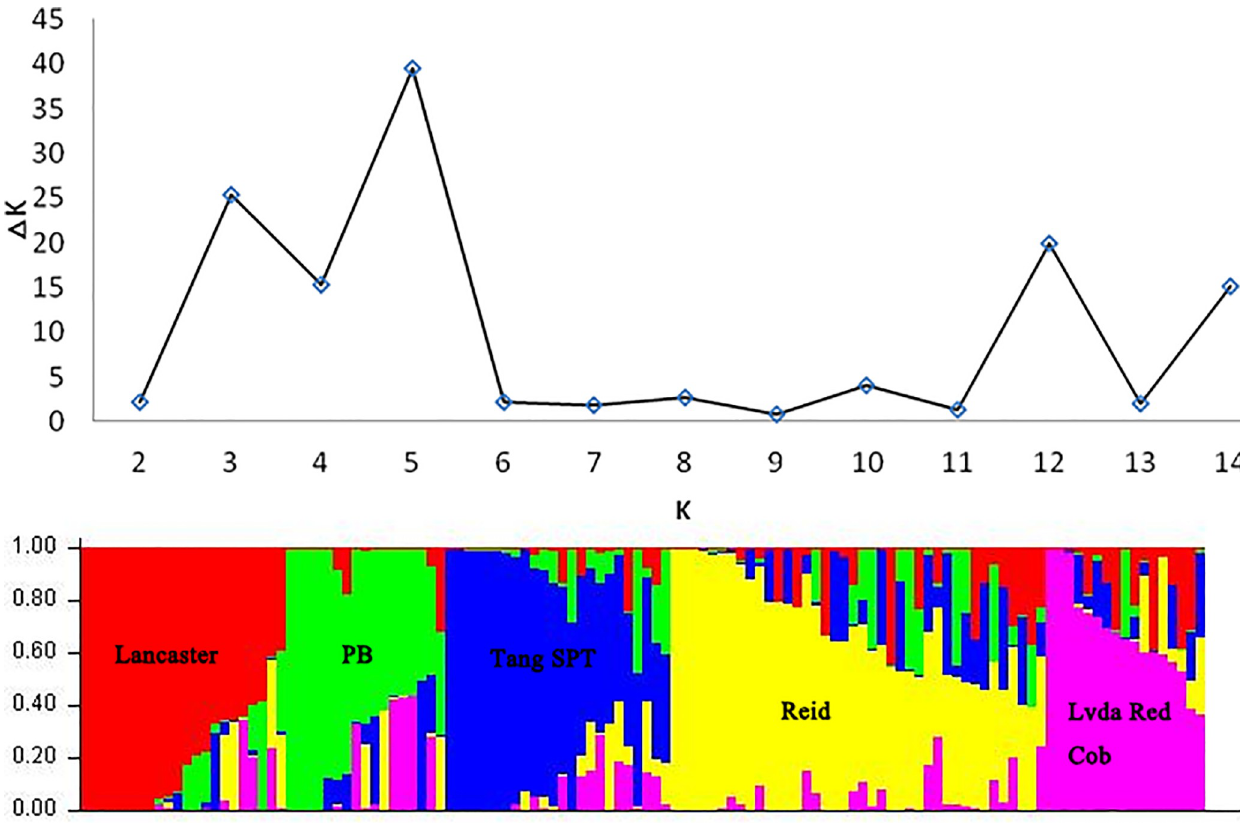
Fig 1. Population structure of 120 maize inbred lines.